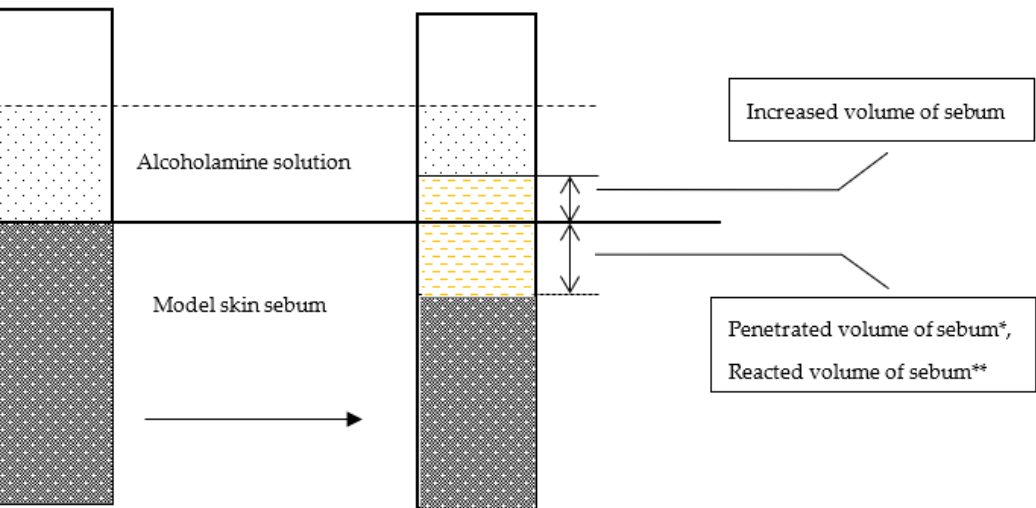
Figure 8. Increased and penetrated volume of model skin sebum calculated using the optical method, the computer program, and the reacted volume of model skin sebum based on the measurements of changes in the pH of the AMPD solution, modified according to a previous study [9]. * Penetrated volume of the sebum was determined via direct optical observation. ** Reacted volume of the sebum was calculated from acidity-alkalinity data of the reacting system. The composition of penetrated and increased volume of sebum is of the same origin—sebum components reacted with the AMPD and loosened with water.